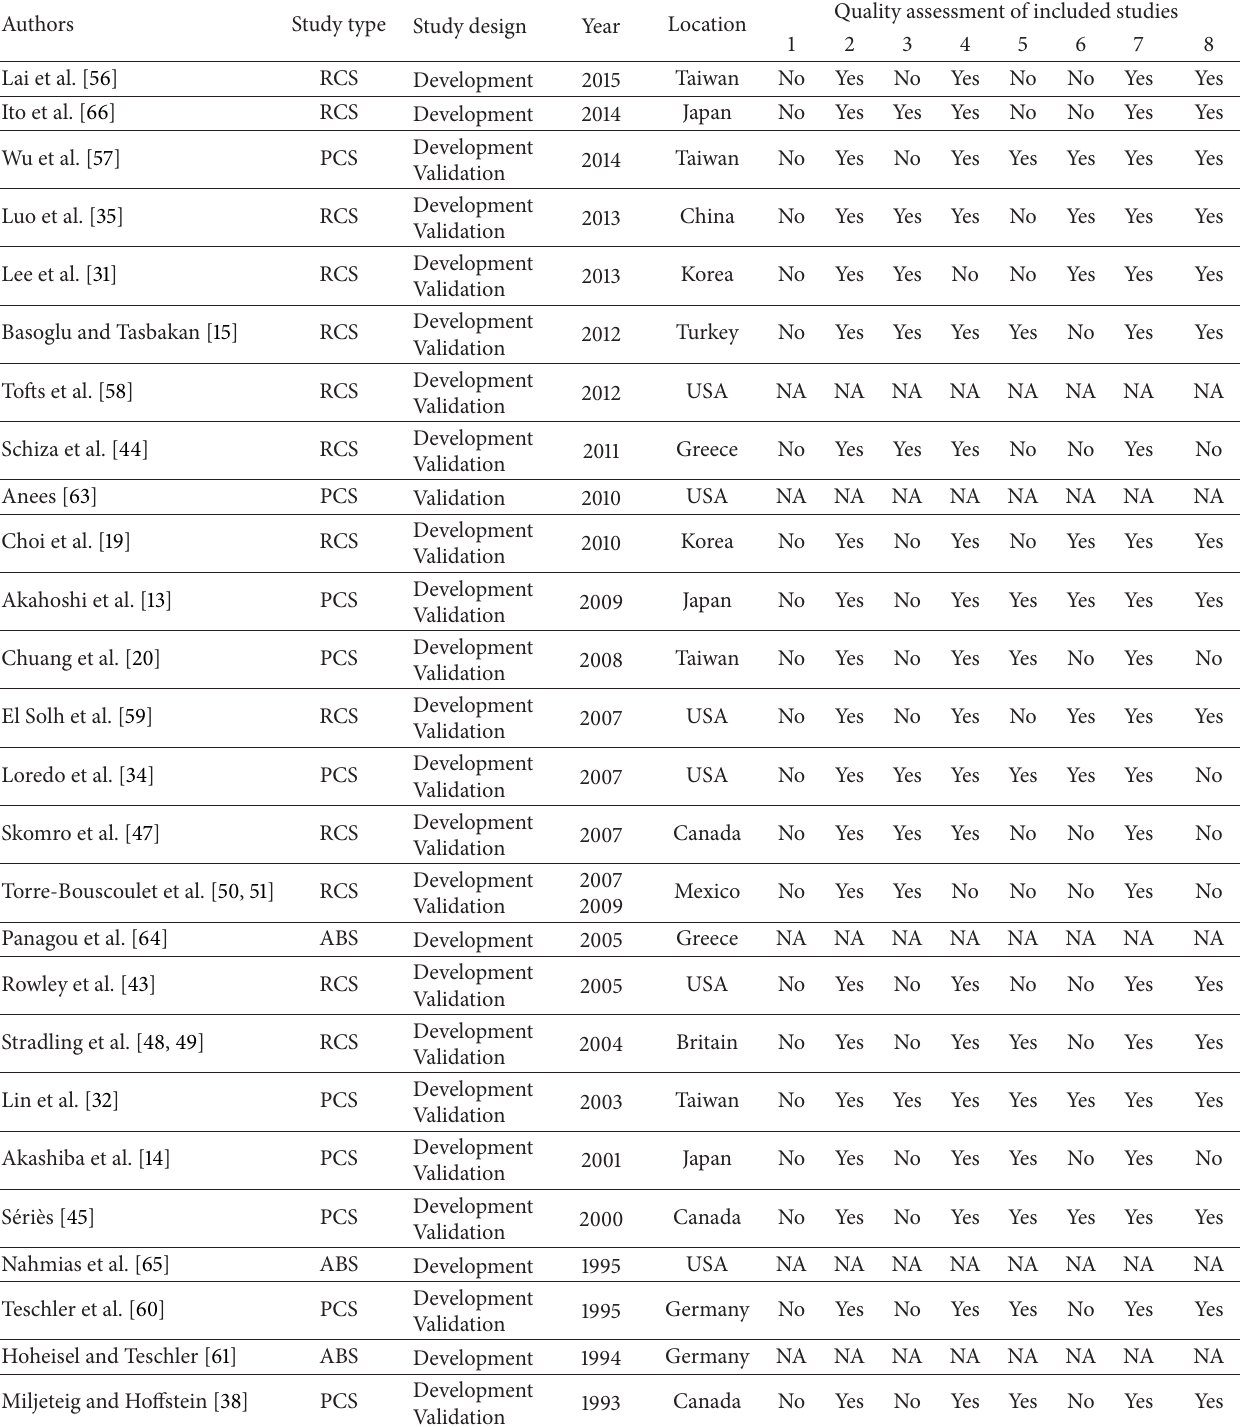
Table 1: Quality assessment of the included studies checklist from questions from National Institute for Health and Clinical Excellence (NICE) 1–8: (1) Is case series collected in more than one center? (2) Is the hypothesis/aim/objective of the study clearly described? (3) Are the inclusionandexclusioncriteriaclearlyreported?(4)Isthereacleardefinitionoftheoutcomesreported?(5)Weredatacollectedprospectively? (6) Is there an explicit statement that patients were recruited consecutively? (7) Are the main findings of the study clearly described? (8) Are outcomes stratified? Abbreviations: ABS = abstract; NA = not applicable (abstract); PCS = prospective case series; RCS = retrospective case